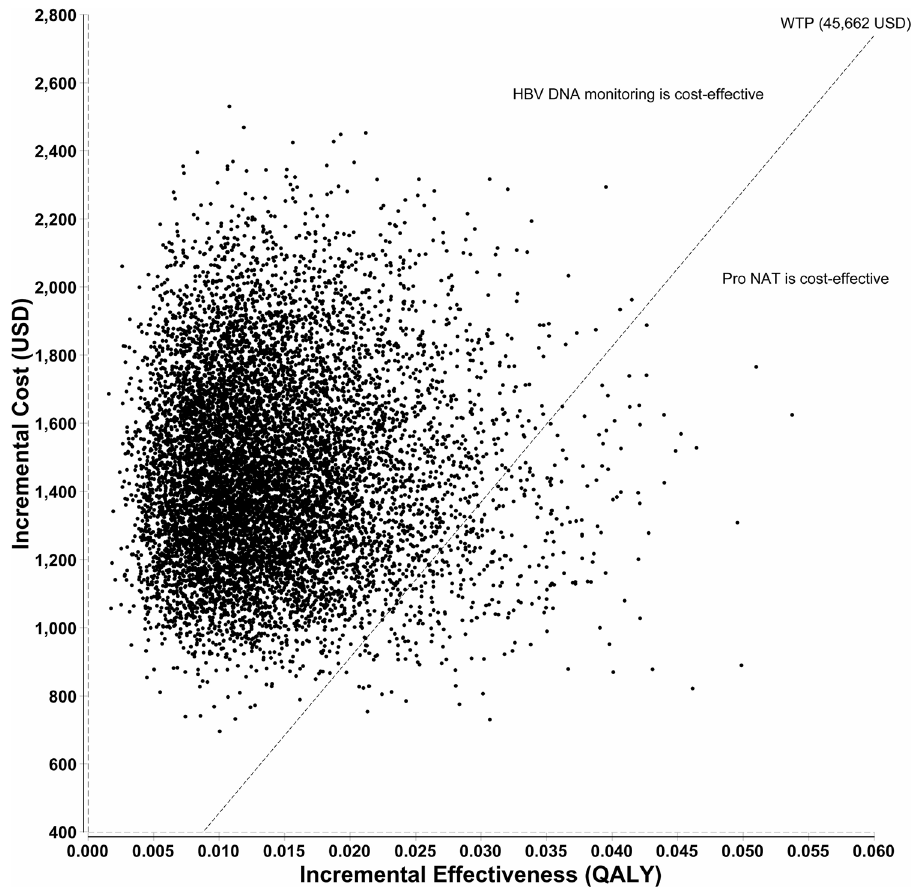
Figure 3. Result of the probabilistic sensitivity analysis. HBV DNA monitoring: HBV DNA monitoring followed by on-demand antiviral therapy; Pro NAT: Prophylactic anti-HBV nucleos(t)ide therapy; QALY: quality-adjusted life-year; USD: US dollar; WTP: Willingness to pay. Incremental cost was calculated by subtracting cost in HBV DNA monitoring from that in Pro NAT. Incremental effectiveness was calculated by subtracting QALY in HBV DNA monitoring from that in Pro NAT. Dots above and below the dotted lines indicate that HBV DNA monitoring is more or less cost-effective than Pro NAT, respectively. Costs in USD. Japanese yen was converted into US dollars using the July 20, 2021 exchange rate: USD 1 = JPY